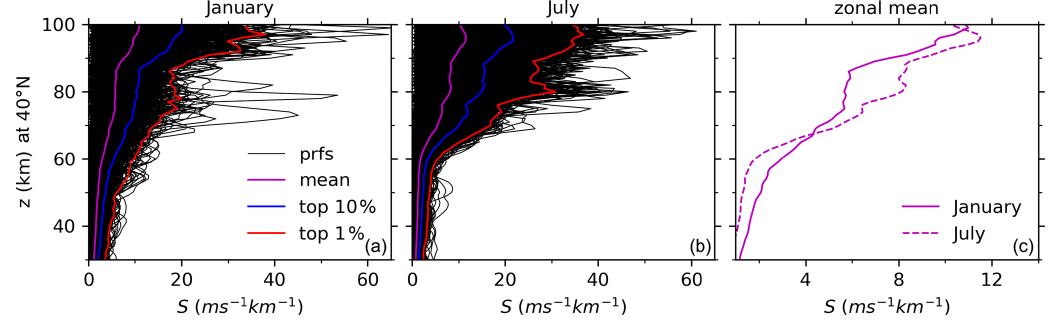
Figure 13. Same as Fig. 5 but for the GW-perturbed profiles derived under the medium-frequency assumption f/ ˆ ω j = 0 and at 40 ◦ N.